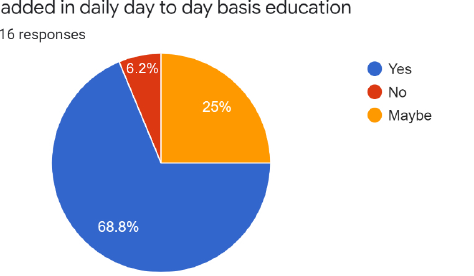
Fig. 6 Response towards the e-learning methods in